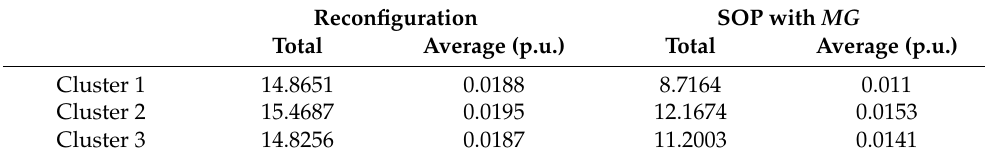
Table 5. Voltage deviation